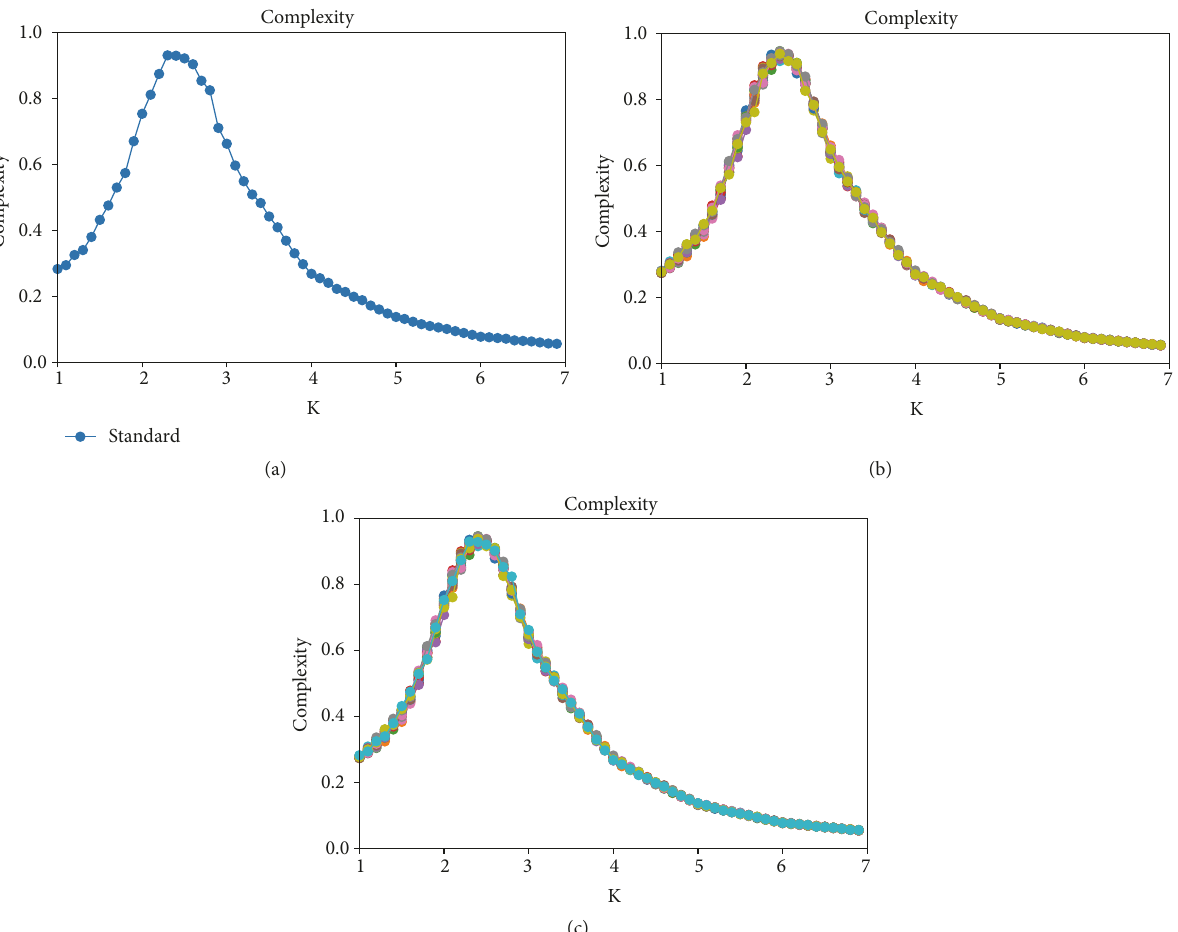
Figure 10: Complexity of standard and antimodular RBNs. (a) Standard network. (b) Modular networks. (c) Overlapped